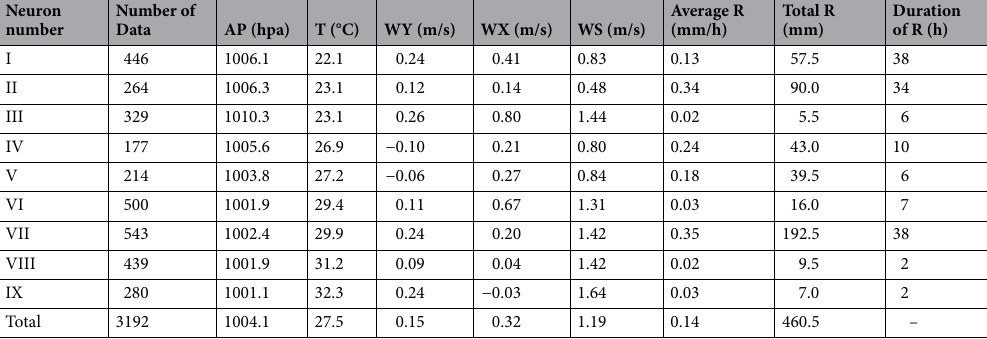
Table 2. Detailed information for each variable in neurons of the